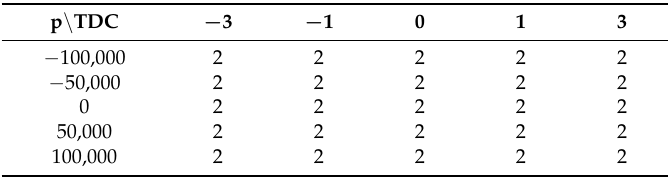
Table 8. Number of iterations for the PSA engine and operating point 2000 1/min and 100 Nm using the off-line method.